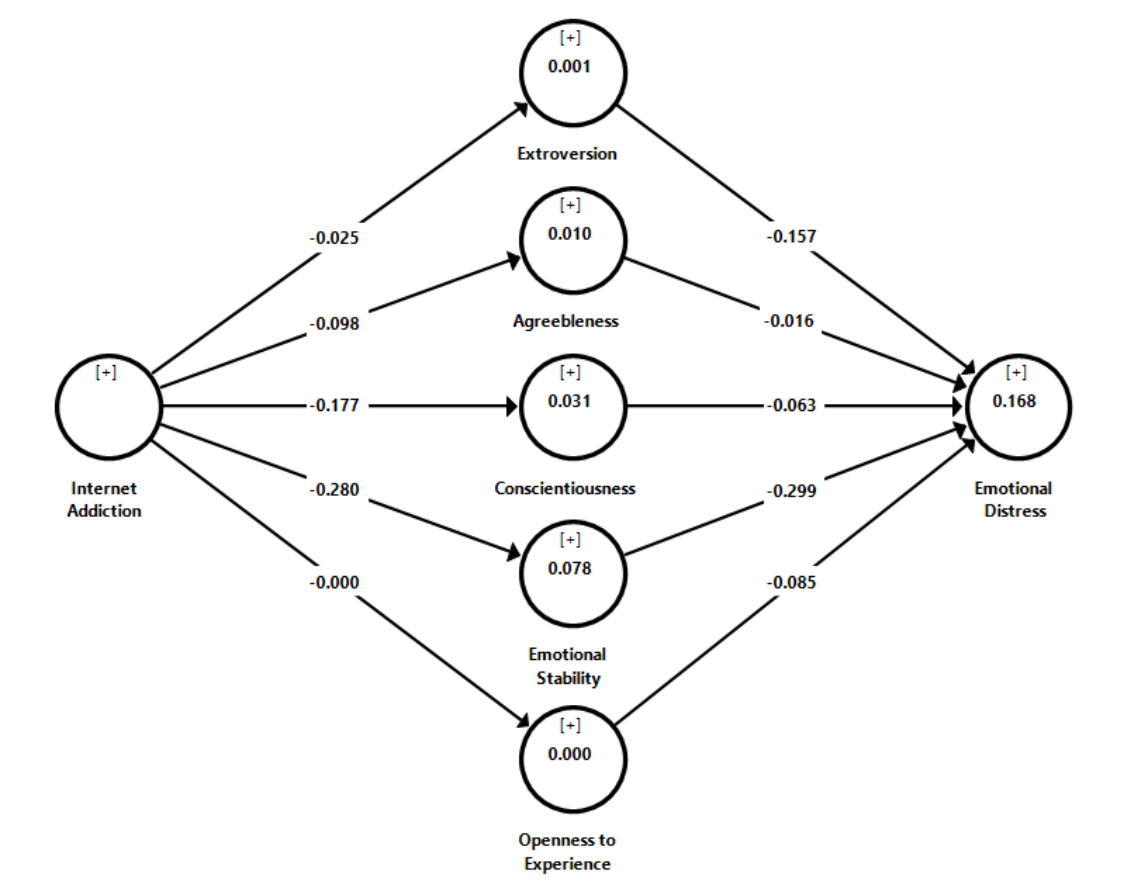
Figure 1. Results of structural